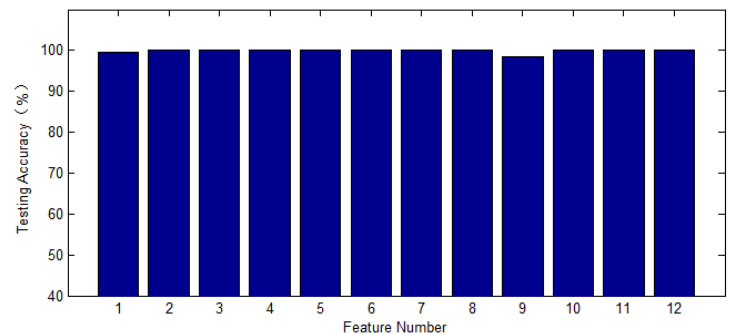
Figure 18. Diagnosis result of the fault severity of the outer race under different features. 1: Ma ; 2: Mi ; 3: P k ; 4: A v ; 5: st ; 6: k u ; 7: rm ; 8: S ; 9: C ; 10: I ; 11: L ; 12: decision fusion.